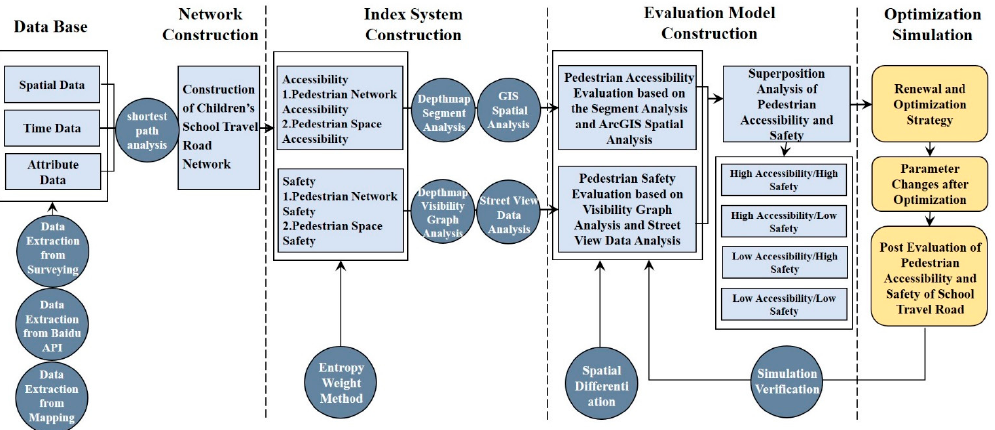
Figure 3. Technical route.